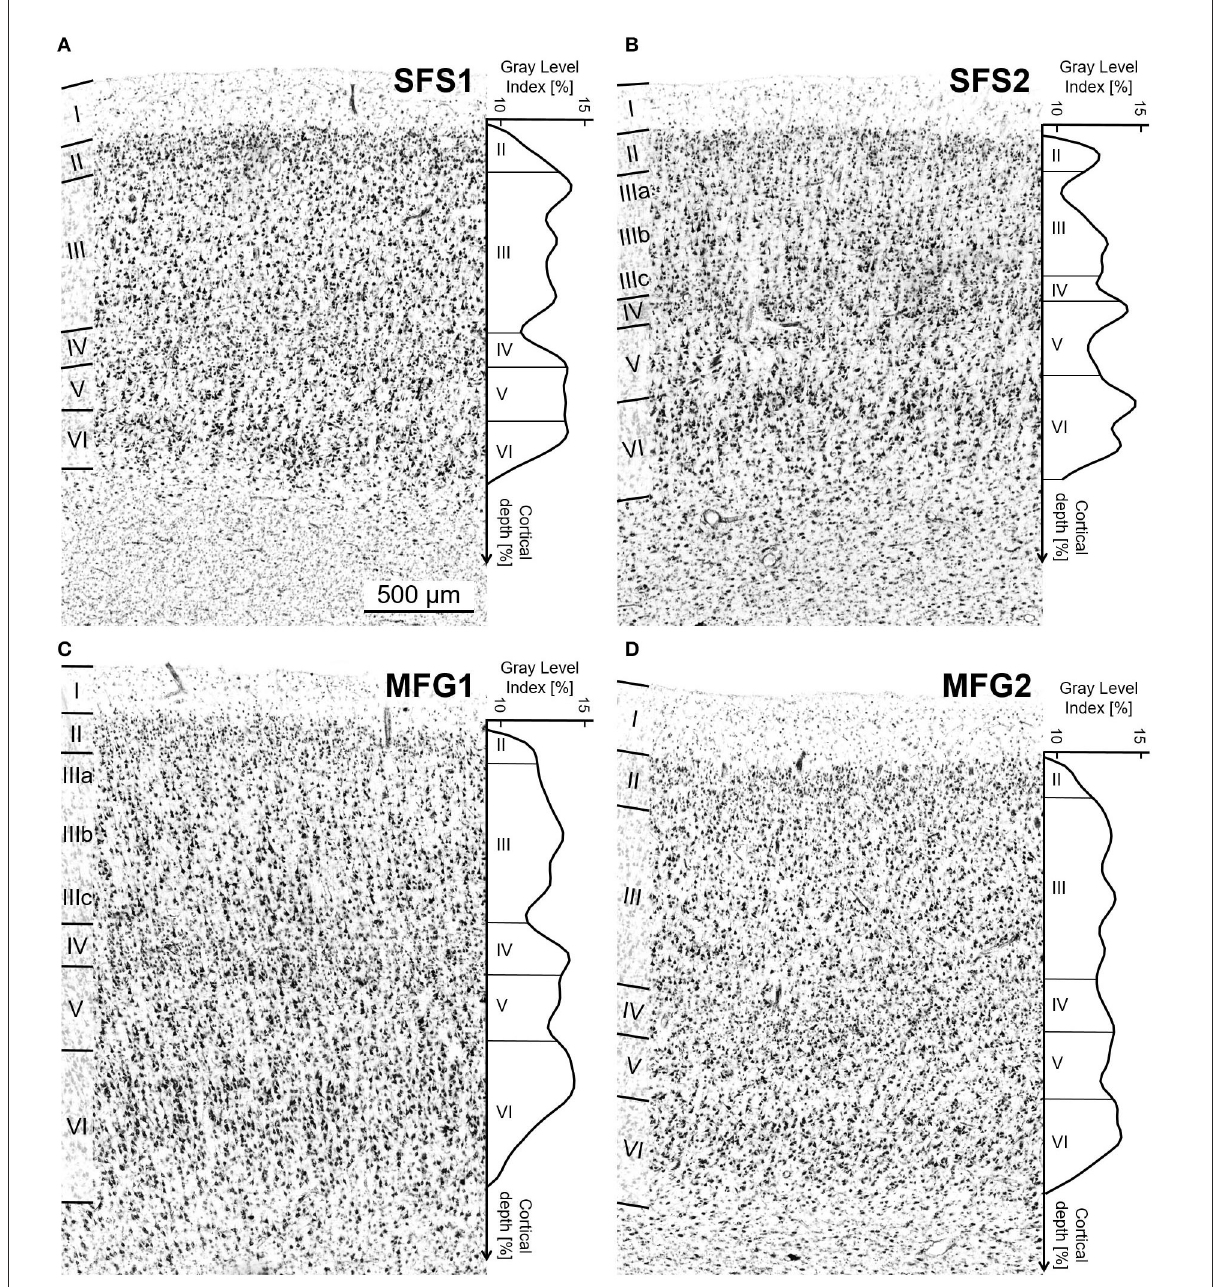
FIGURE3 Cytoarchitecture of areas SFS1, SFS2, MFG1, and MFG2 with corresponding mean GLI profiles. The GLI profiles, next to the histologic images, reflect the laminar changes in the volume fraction of cell bodies and, thus, the distinct cytoarchitecture. The statistical image analysis was based on these GLI profiles. Area SFS1 was characterized by a cell dense layer III with medium-sized pyramidal cells and a well-developed layer IV compared to neighboring areas BA9 and SFS2. Layer V was not subdividable, and the border between the thin layer VI and the white matter was sharp (A) . The most characteristic criteria for identifying area SFS2 was the thin blurry layer IV due to large pyramidal cells in deeper layer III and upper layer V. Layer IIIa was loosely packed, and layer VI was very prominent with large cells (B) . Typical for area MFG1 were large pyramidal cells in deeper layer III and upper layer V. Layer VI was prominent and cell-rich with a blurry transition to the white matter (C) . Area MFG2 was characterized by a relative homogenous cell size across all layers, a broad well-developed layer IV, and a sharp transition to white matter (D) . Contrast of histological images was enhanced for better visualization. Scale bar 500 µ m in (A) refers to all (A–D)